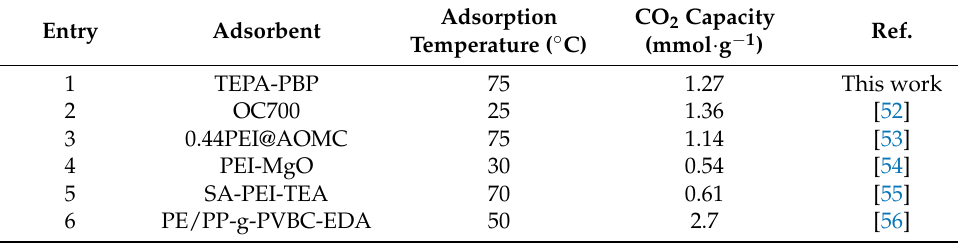
Table 3. Comparison of the CO 2 adsorption performance of TEPA-PBP with advanced